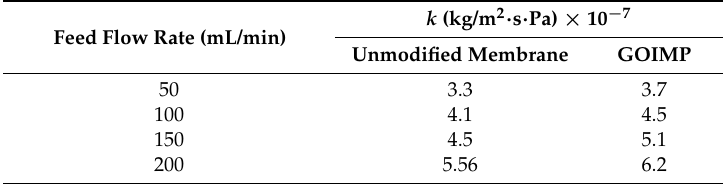
Table 1. Effect of varying feed flow rate on mass transfer coefficient at 60 ◦